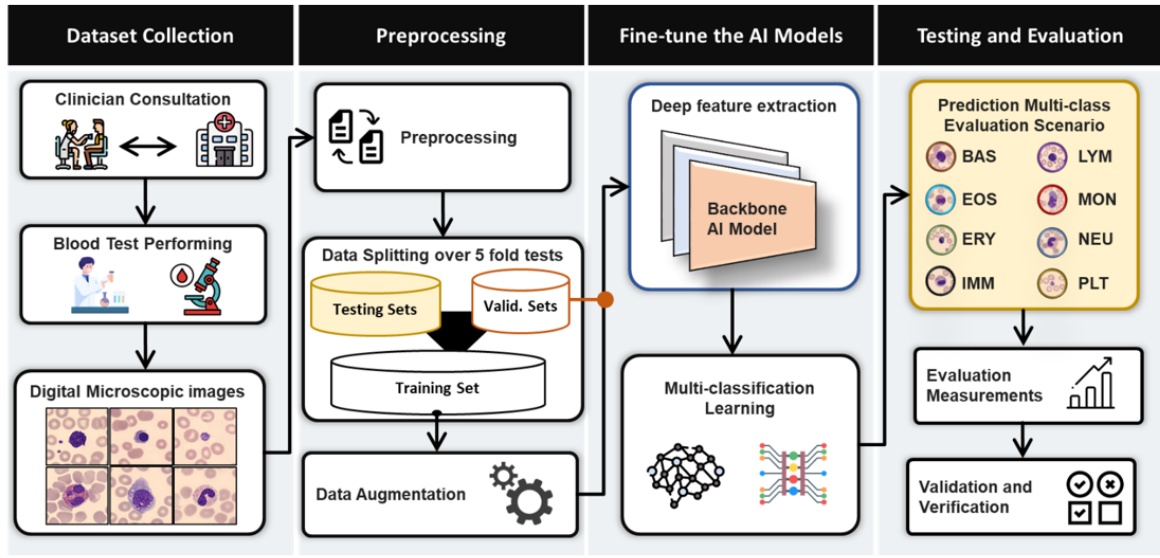
Figure 3. Abstract view paradigm of the proposed BCNet for blood cell multi-class identifications.